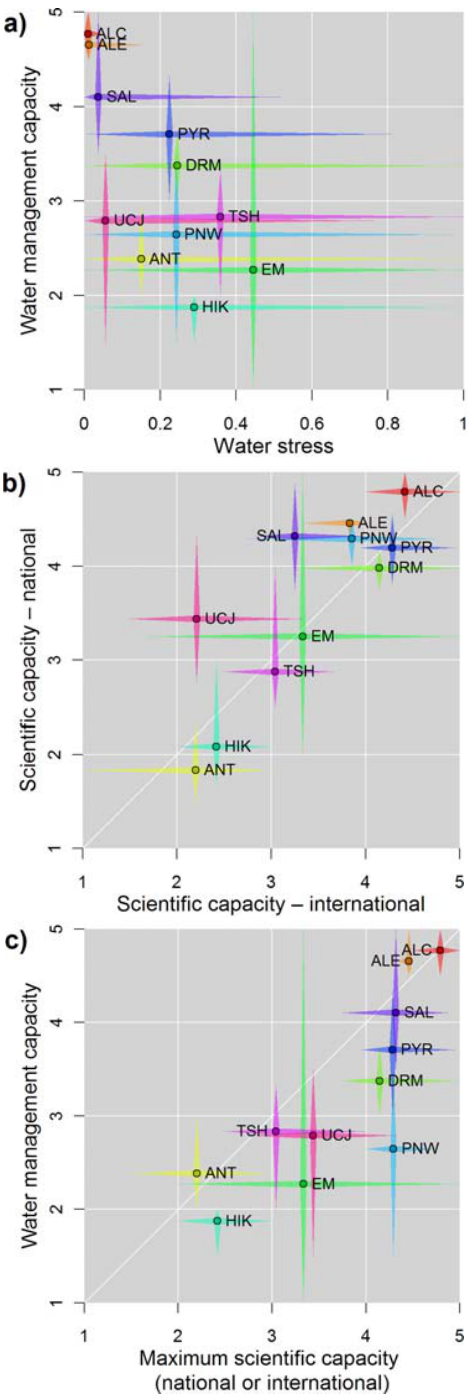
Fig. 2. Characterisation of the regions studied with regard to (a) water stress and water management capacity to adapt to climate change; (b) national and international scientific capacity regarding climate change and water resources issues; (c) water management capacity to adapt to climate change and maximum scientific capac- ity (regardless whether of national or international origin) regarding climate change and water resources issues. The coloured bars indi- cate the range of